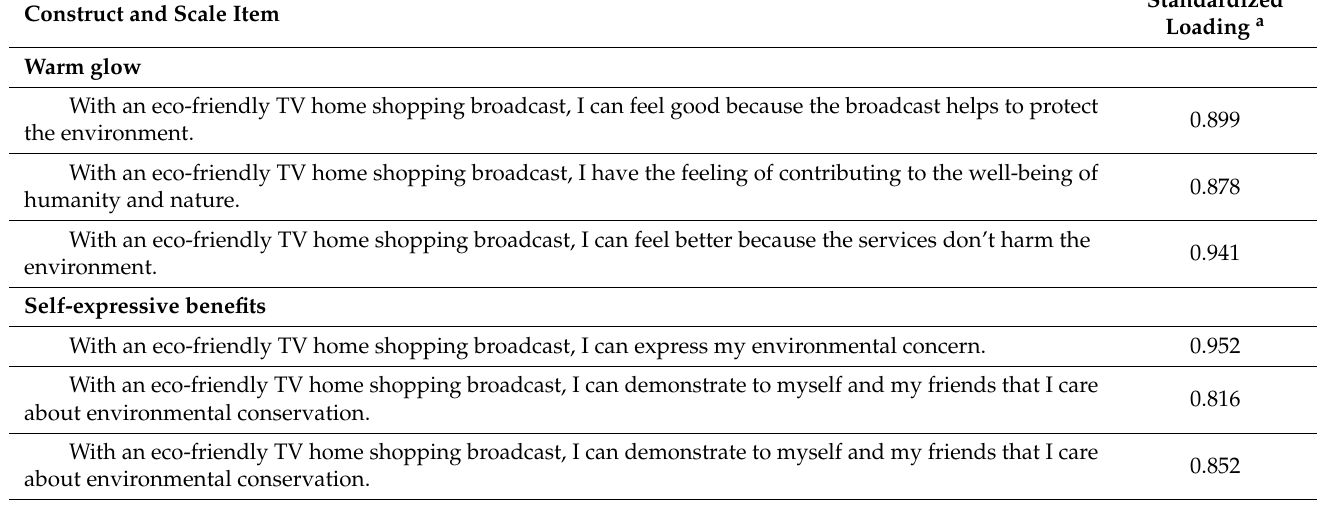
Table 2. Confirmatory factor analysis: items and